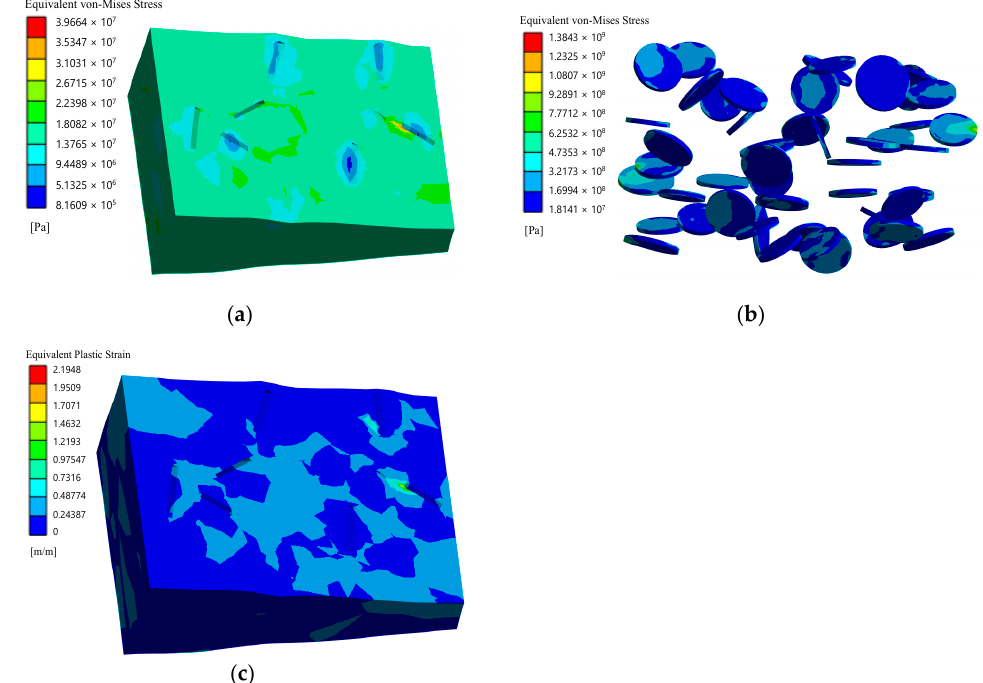
Figure 11. Equivalent stresses according to von Mises stress, Pa for matrix ( a ) and filler ( b ) and equivalent plastic strain ( c ) with short cylindrical filler at the moment of loss of bearing capacity (first stage).